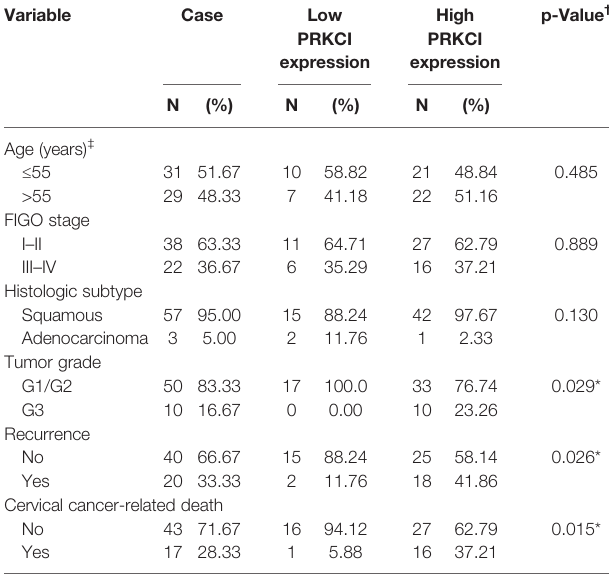
TABLE 1 | Associations between PRKCI expression and clinicopathologic characteristics in CC. Variable